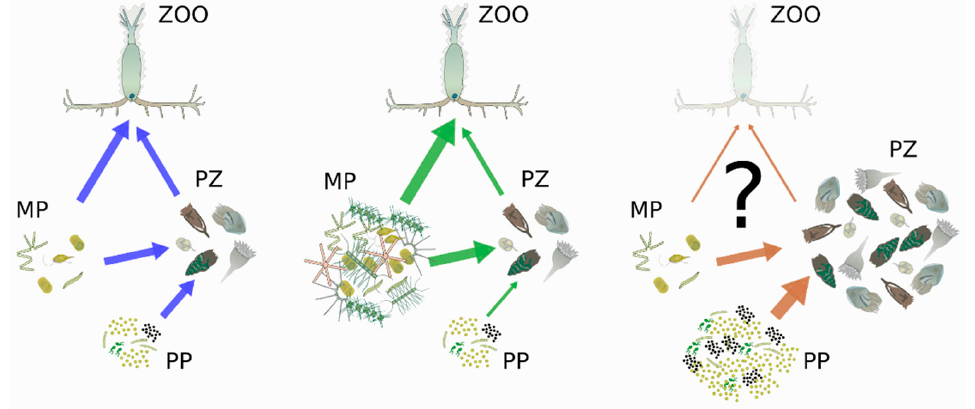
Figure 3. Scheme of changes in matter fluxes within plankton as driven by changes in water quality (from blue to green to brown, i.e., at increasing levels of freshwater inputs). PP = picoplankton; MP = microplankton; PZ = protozooplankton; ZOO = mesozooplankton. Drawings based on the open-source IAN symbol library (https://ian.umces.edu/media-library/symbols/, accessed on 1 November 2021). Arrows indicate trophic links and go from prey to predators; arrow width is proportional to the amount of matter being transferred between prey and predator. Blue and green links are based on D’Alelio et al., 2016 [64]. The brown links are